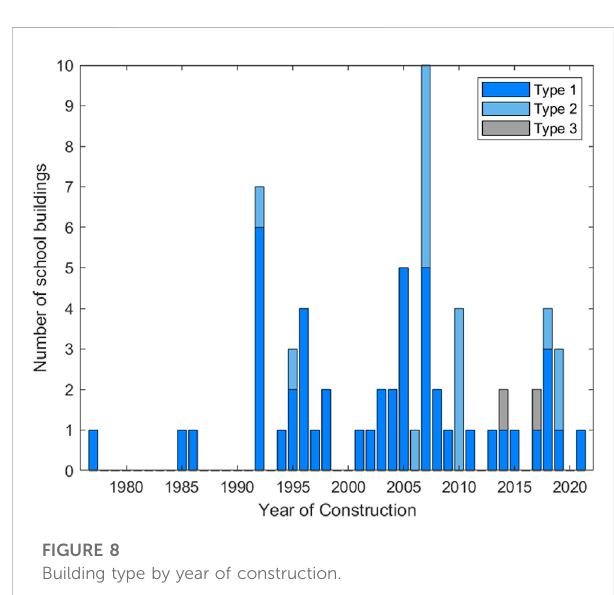
FIGURE 8 Building type by year of